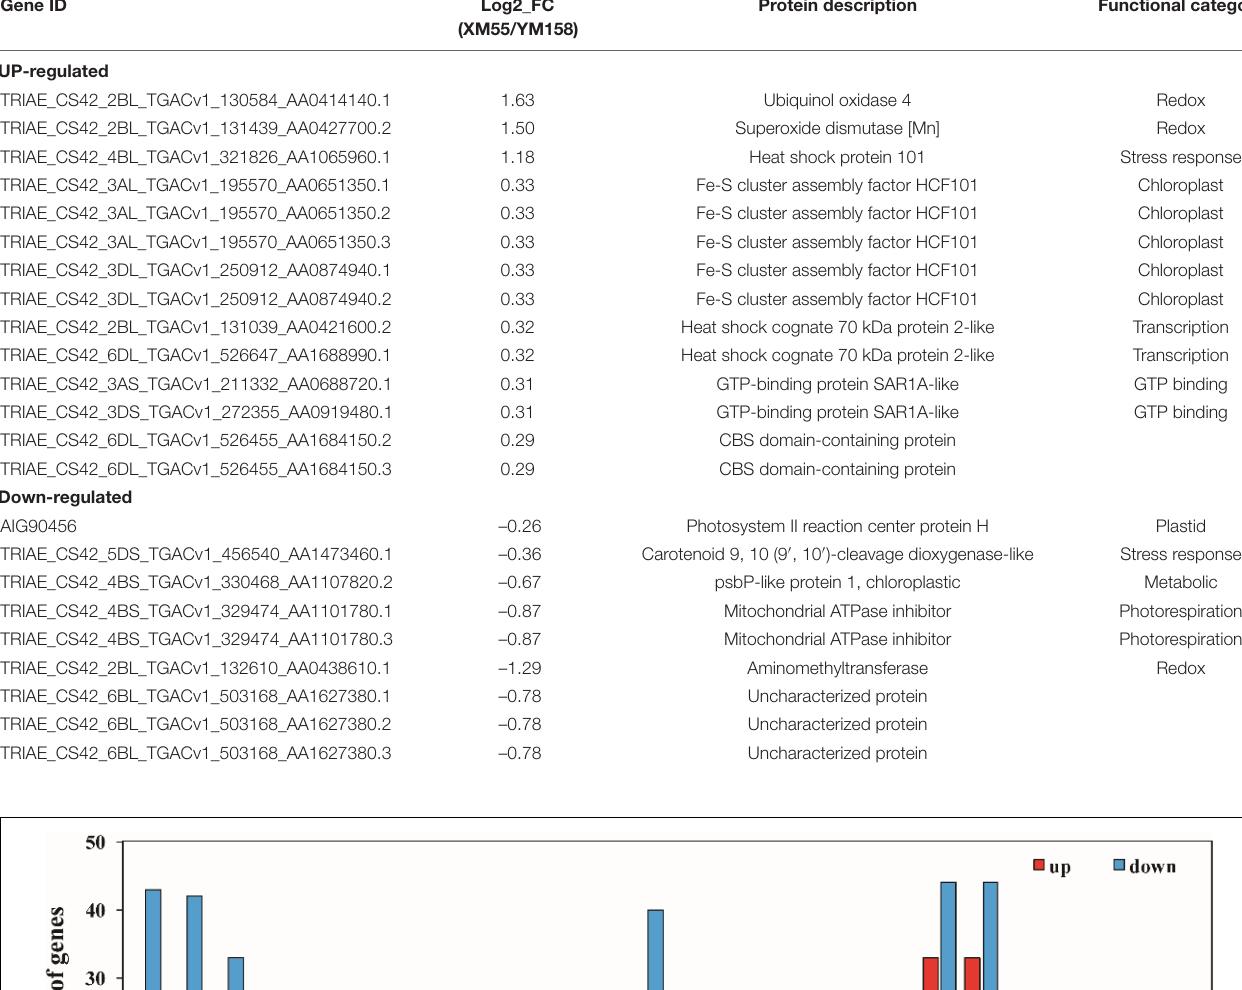
TABLE 2 | Differentially expressed proteins between XM 55 and YM 158 under WL.